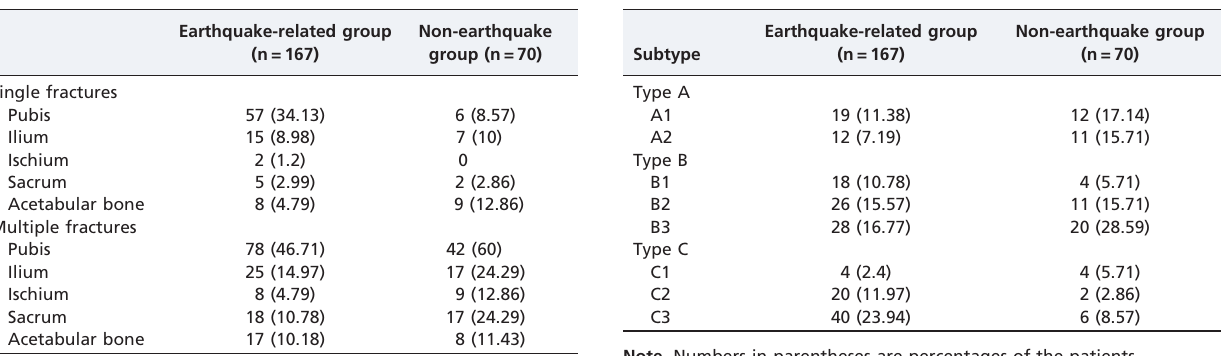
Table 4 - Patients with pelvic single and multiple fractures according to each pelvic bone involved.